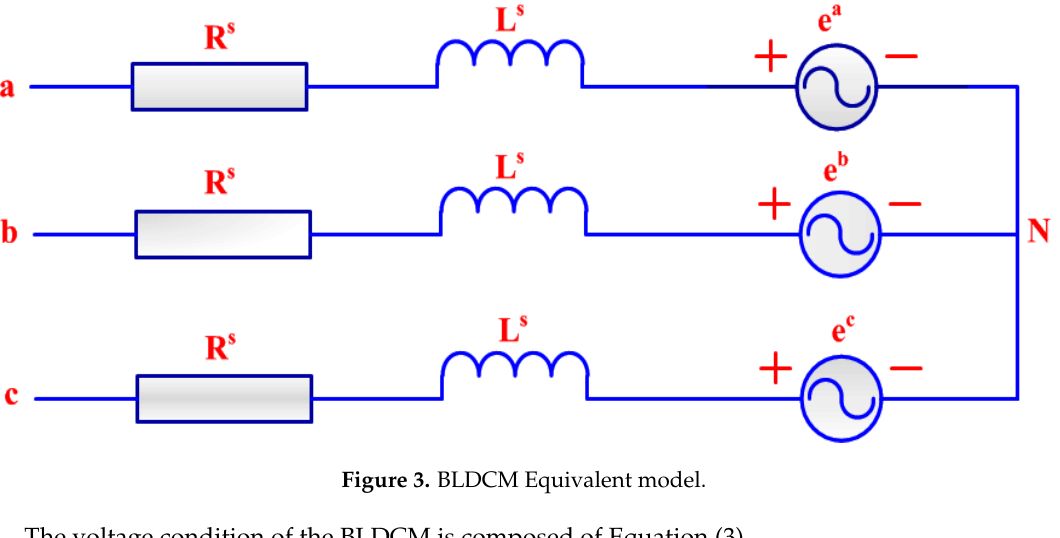
Figure 3. BLDCM Equivalent model.